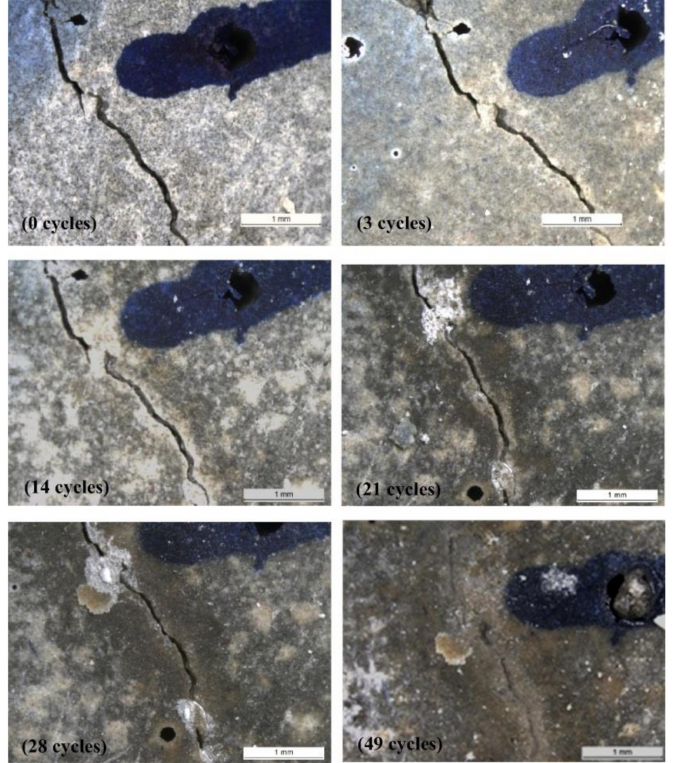
Figure 7. Closure of a 100 µ m crack in an OPC M (0.45) sample cyclically exposed to 33 g/L NaCl (Adapted with permission from Elsevier